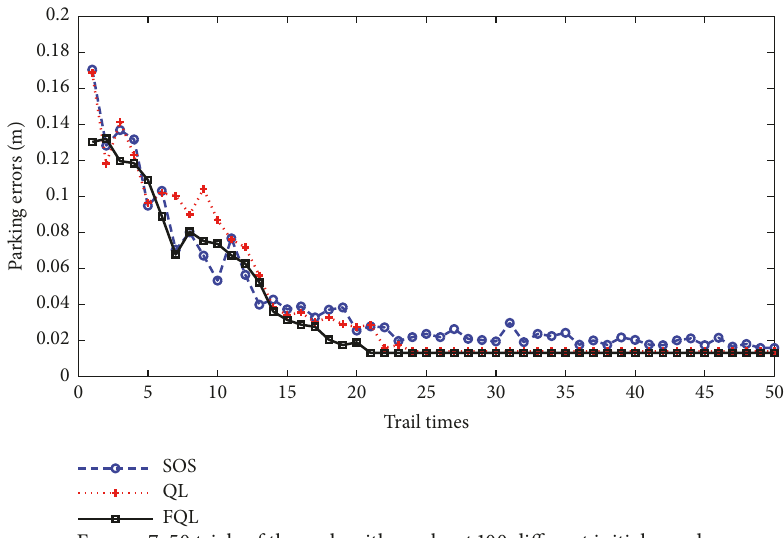
Figure 7: 50 trials of three algorithms about 100 different initial